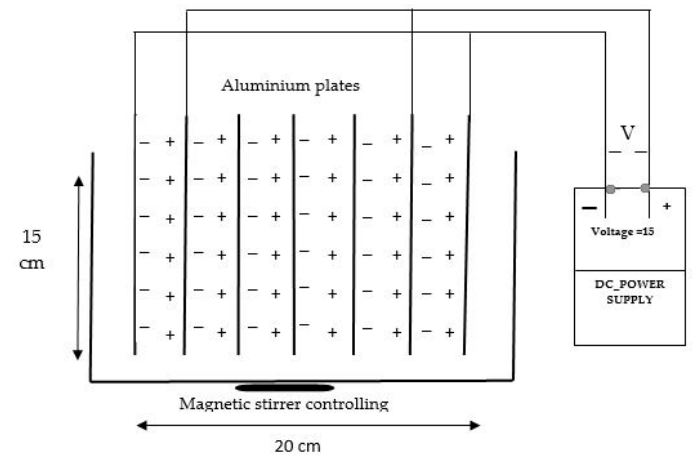
Figure 2. Experimental setup of the electrocoagulation (EC) process.